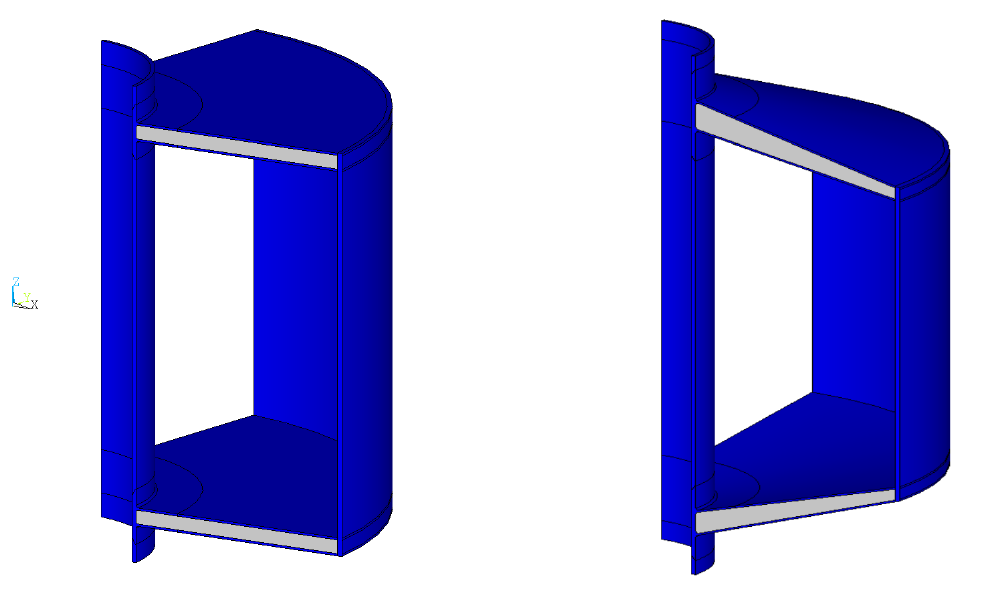
Figure 5. A 3D view of the Universal Buoyancy Body with flat covers on the left, and conical shaped covers on the